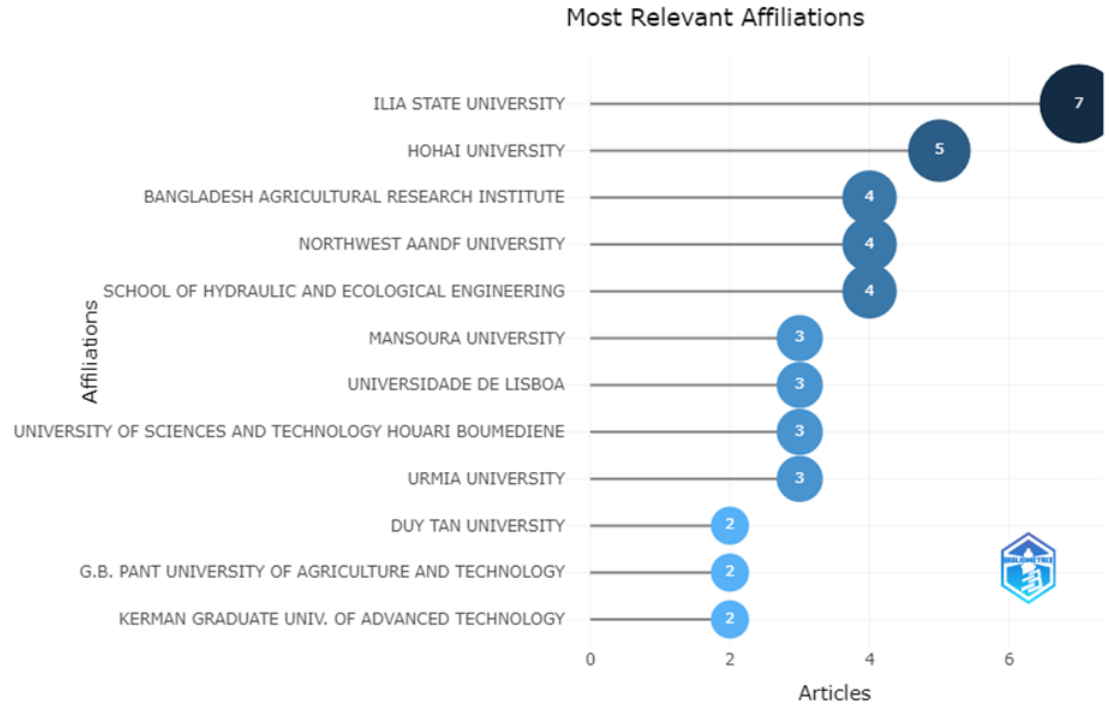
Figure 5. A delivers key terms from the research literature.